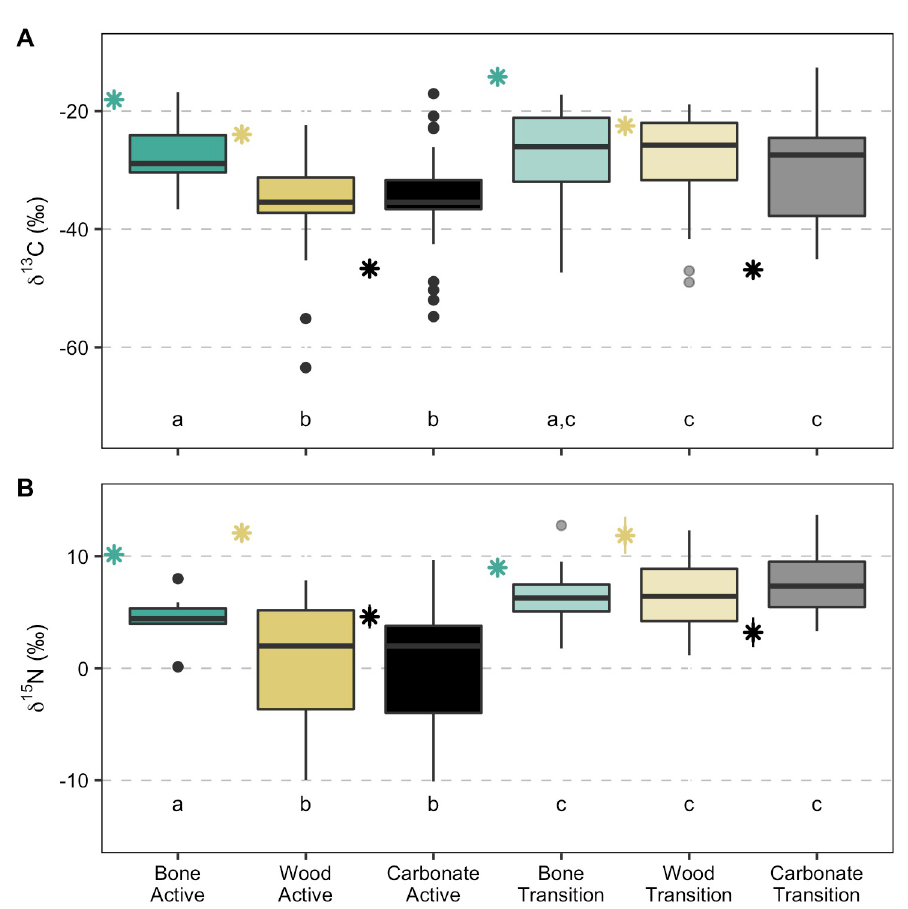
Fig 7. Isotopic composition of macrofaunal colonizers on the experimental substrates. (A) δ 13 C and (B) δ 15 N values (‰) of macrofauna invertebrates colonizing experimental bones, wood and carbonate rocks deployed for 7.4 years (2010–2017) at active and transition sites at Mound 12 and mean ( ± 1 standard deviation) isotopic composition of each substrate at active and transition sites (stars). Boxplots represent five summary statistics: the mean, two hinges (the 25 th and 75 th percentiles), and two whiskers (extend from the hinge to the largest/smallest value at 1.5x the inter- quartile range), as well as outlying points individually. Isotope data are available in S1 File.